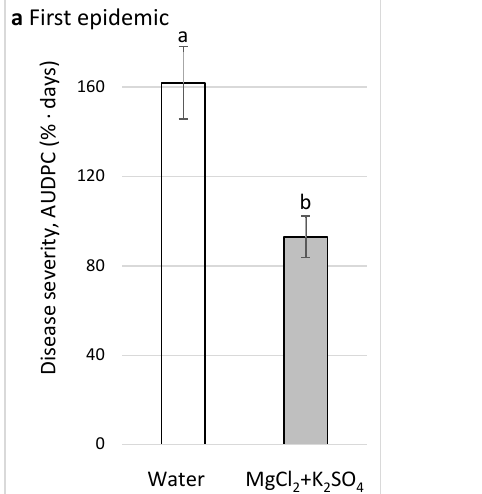
the differences between treatments were insignificant; hence, the detailed yields are not presented.